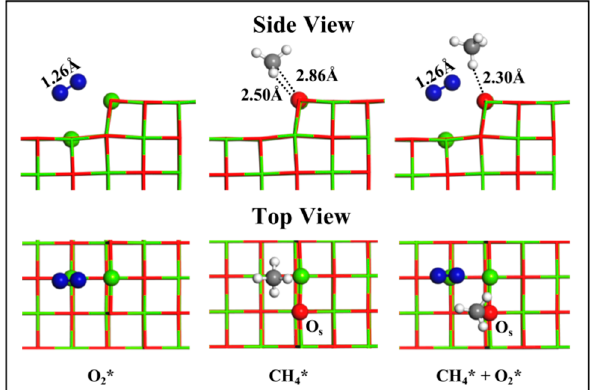
Figure 1. The optimized structures of adsorption and co-adsorption of CH 4 and O 2 . Mg: green; Carbon: gray; Hydrogen: white; Oxygen (oxygen molecule): blue; Oxygen (MgO): red. The same color code applied in following figures, “*” indicated the surface adsorbed spices.